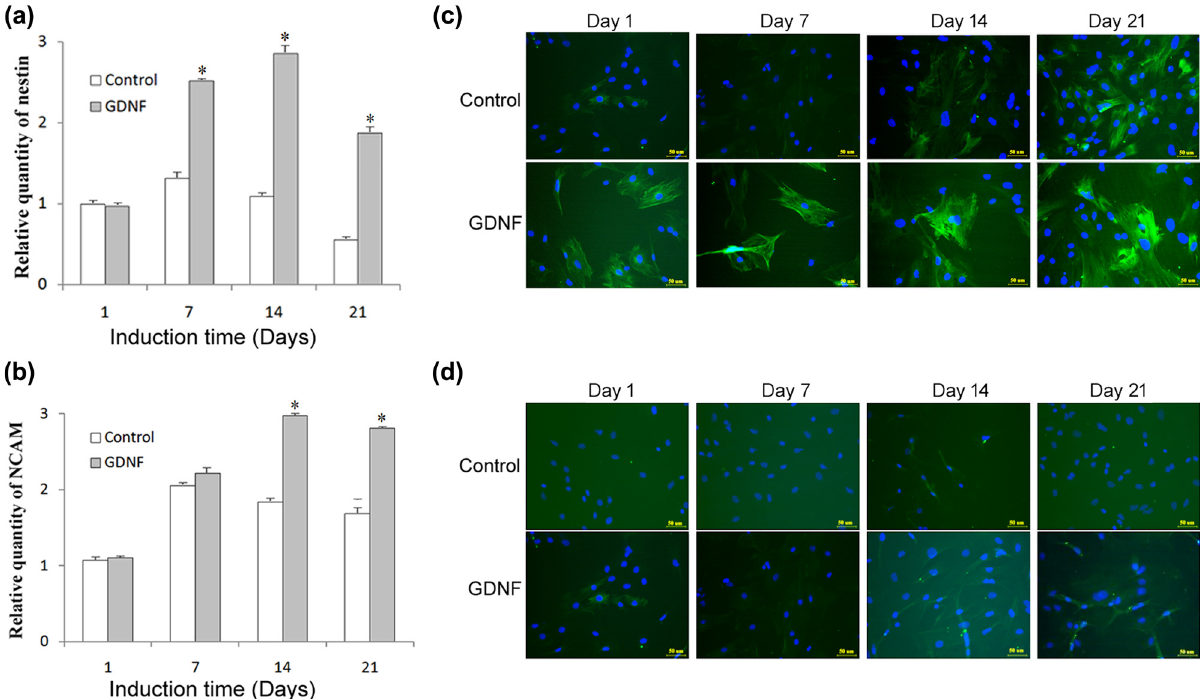
Figure 3: Detection of the levels of nestin and NCAM. ( a and b ) Expression of nestin and NCAM under GDNF induction were examined by qRT - PCR. ( c and d ) Expression of nestin and NCAM also analyzed by immuno fl uorescence. * p < 0.05 compared with the control